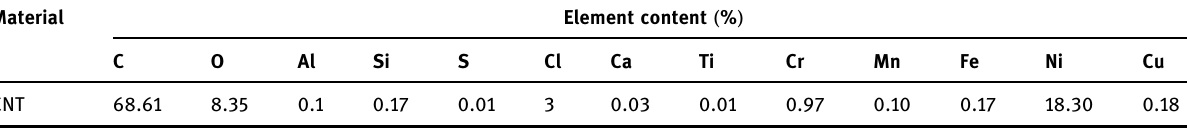
Table 4: Chemical composition of CNTs Material